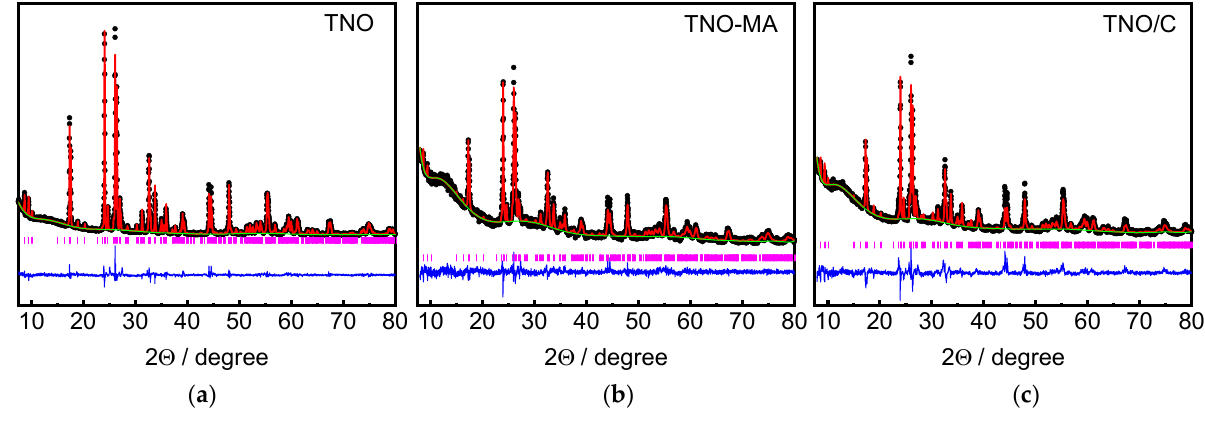
Figure 2. Rietveld refined XRD patterns of ( a ) TNO, ( b ) TNO-MA, and ( c ) TNO/C. Table 1. Refined lattice parameters of TiNb 2 O 7